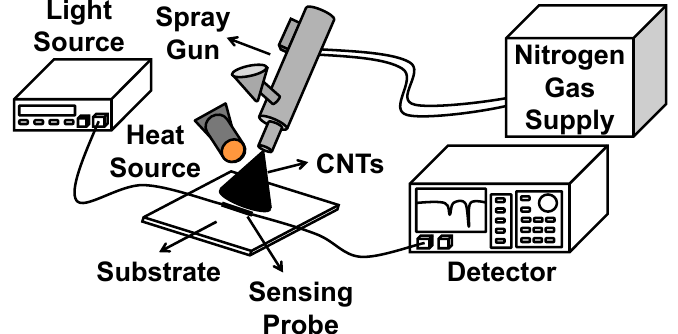
Figure 5. Schematic of the experimental set up for spray coating of CNTs onto an optical fibre sensing probe.